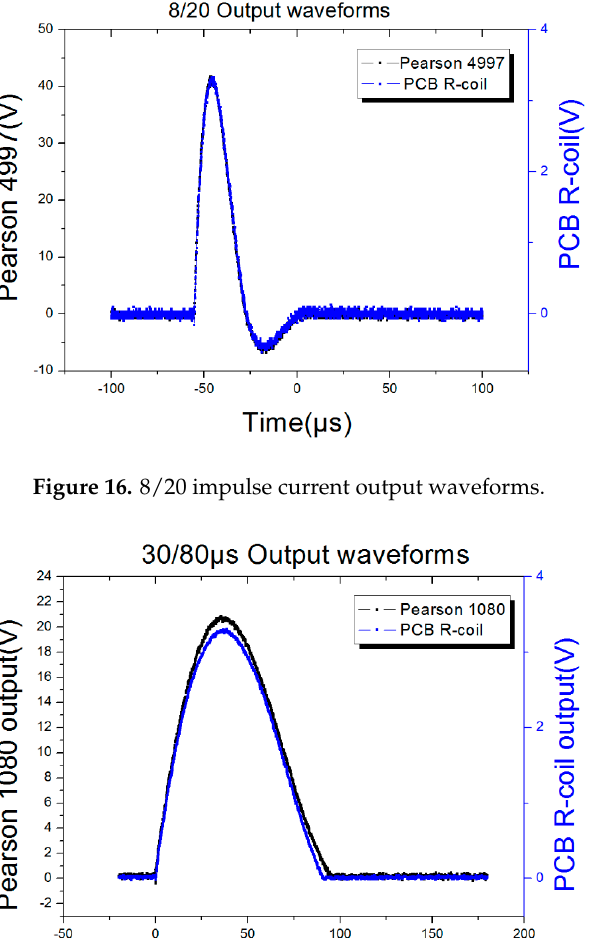
Figure 15. 50 Hz output waveforms.